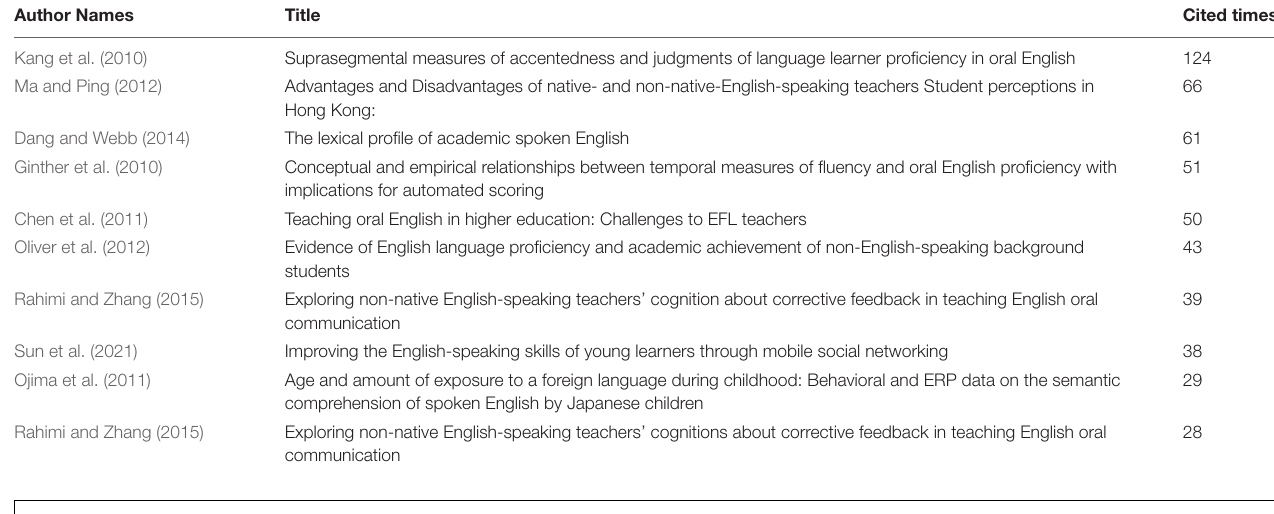
TABLE 4 | Top 10 frequently cited authors on English-speaking (ES) education in Scopus (2010–2021).